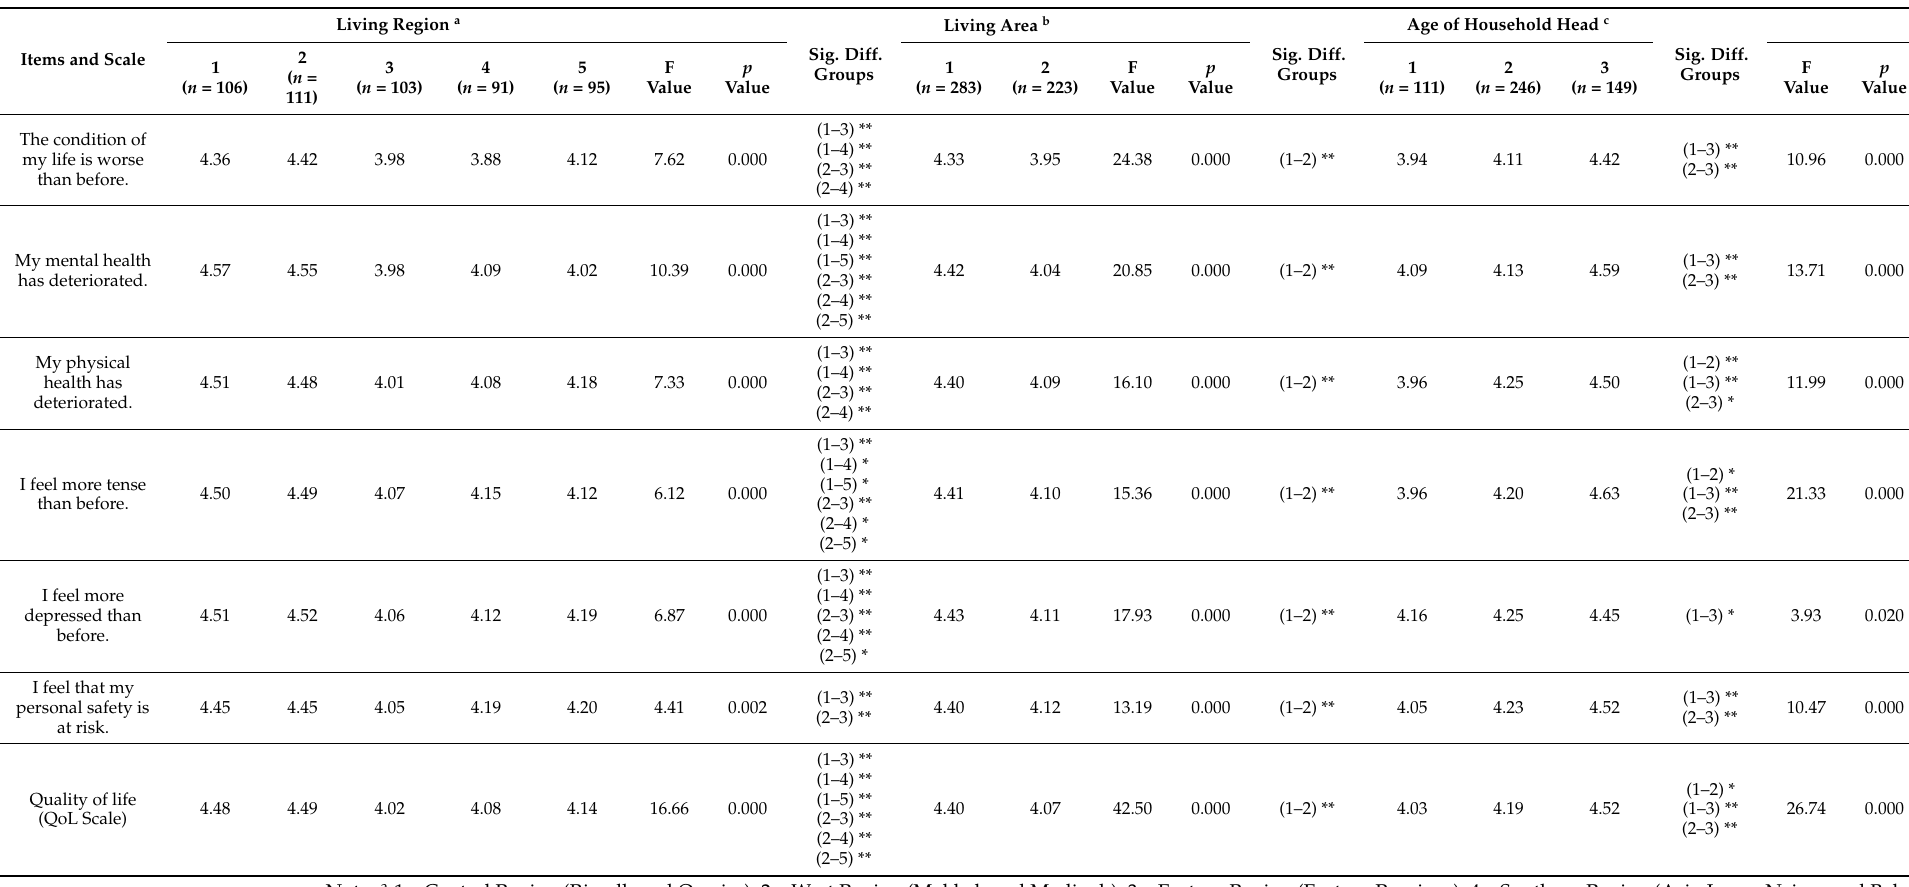
Table 2. ANOVA for mean scores of respondents on QoL items and QoL scale classified by living regions, living areas, and age of household head.